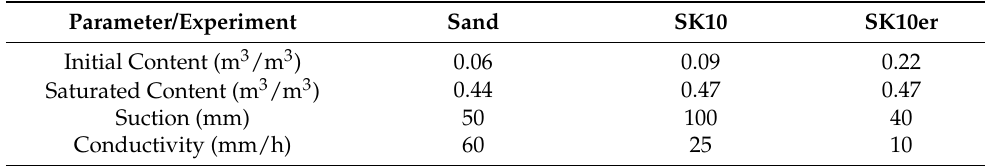
Table 7. Calibrated values of parameters for different experiments using the Green and Ampt method. Initial values are shown in Table 2.